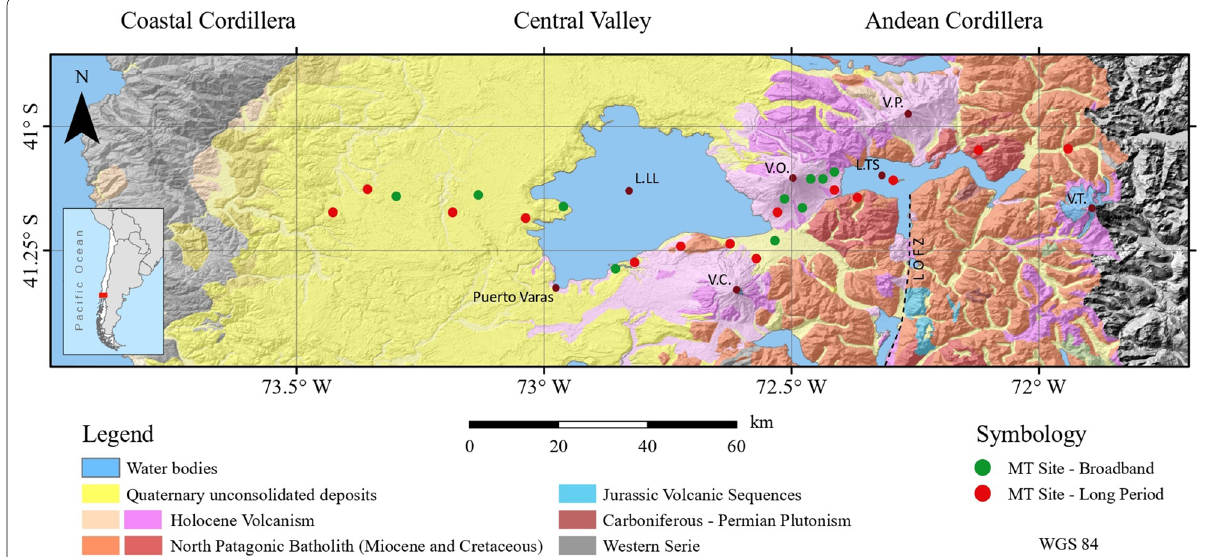
Fig. 1 Study area and location of magnetotelluric sites. From west to east, the main morpho-structures that dominate the study zone correspond to the coastal mountain range that dates from the Paleozoic and is made up of the western series, the central valley made up mainly of marine Cenozoic volcanic rocks and glacial sediments and the Andes mountain range where the Nor-Patagonic batholith is developed, made up mainly of alkaline plutonic rocks from the Middle Jurassic to the Miocene. Dotted line represents the trace of the Liquiñe Ofqui fault zone LOFZ, L.LL Lake Llanquihue, LTS Lake Todos los Santos and VO, VC, VP, VT represents the Osorno, Calbuco, Puntiagudo and Tronador volcanoes